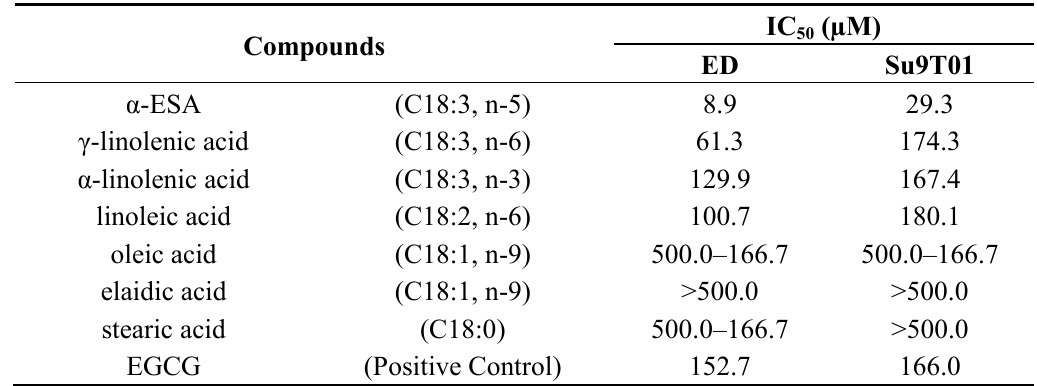
Table 1. Relationship between octadecanoic acid structure and inhibition of adult T-cell leukemia (ATL) cell line